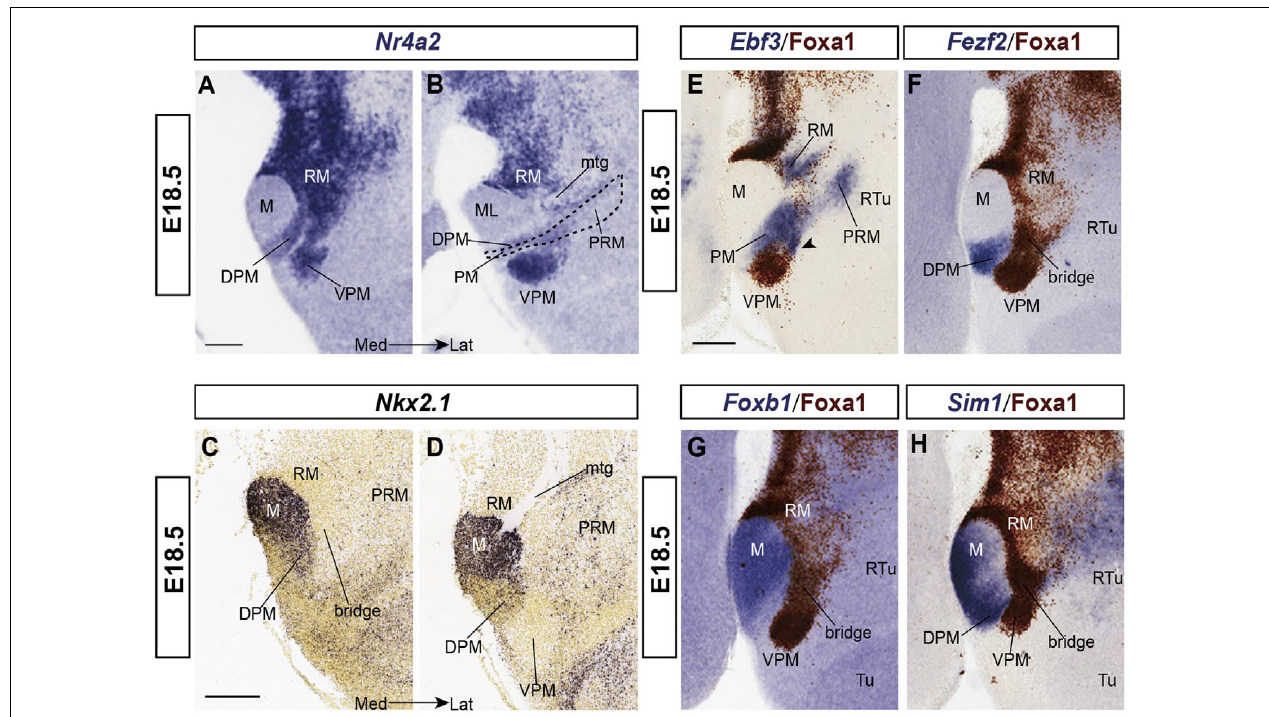
FIGURE 5 | Labeling of some neighboring structures next to RM and VPM at E18.5. (A,B) Two medio-lateral sagittal sections showing the DPM ventral to VPM; this smaller population also seems to migrate out of RM (A) into the PM band (dash line in B ); it is also labeled with Nr4a2 ISH. (C,D) Two medio-lateral sagittal sections from the Allen Developing Mouse Brain Atlas labeled with Nkx2.1 ISH, a widespread basal plate marker in the hypothalamus except at the RM area (C,D) , showing the likewise negative VPMms bridge (C) and VPM (D) areas. (E–H) Ebf3, Fezf2, Foxb1, and Sim1 ISH combined with Foxa1 immunoreaction to show mamillary markers (M in G,H ), perimamillary/periretromamillary labeling (PM/PRM in E ), and DPM signal (in F,H ) next to Foxa1.positive RM, VPMms and VPM. Scale bars represents 200 µ